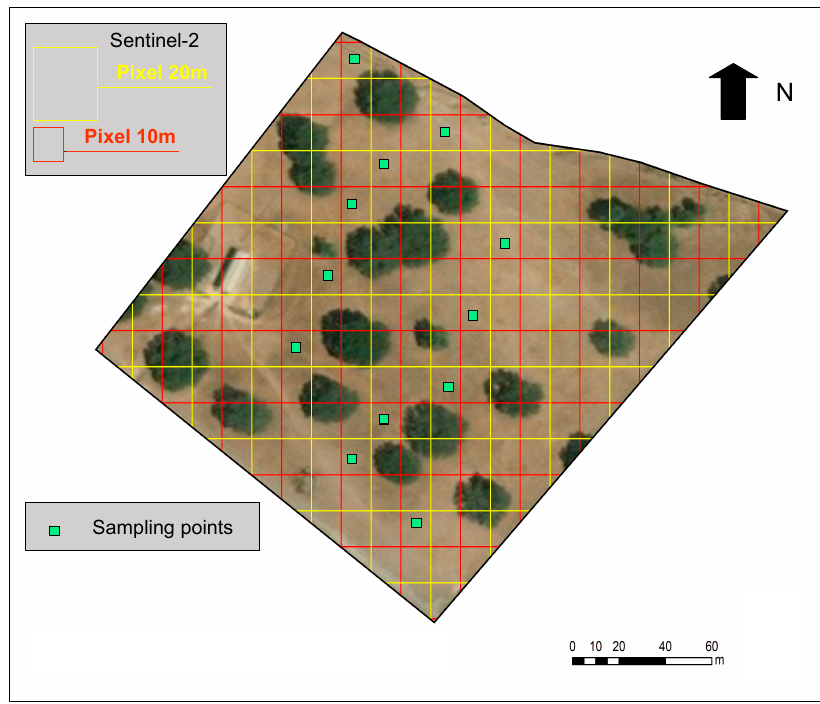
Figure 2. The experimental field showing the sampling points and Sentinel-2 pixel grid (10 and 20 m).